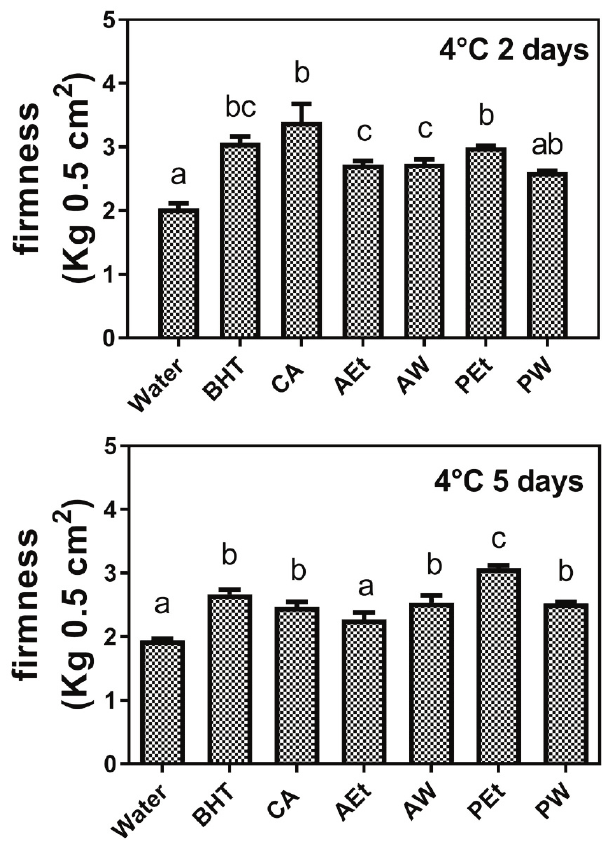
Fig. 4 ­ Cold storage test: effect of dipping on flesh firmness (kg/0.5 cm 2 ) of fresh­cut apples determined at 4°C after 2 and 5 days from dipping treatments: water; BHT (1% butylated hydroxytoluene); CA (1% citric acid); EtA (10% ethanol apple extract); WA (water apple extract); EtP (10% ethanol potato extract); WP (water potato extract). Data are means ± SE. Different letters indicate significant statistical difference at p≤0.05.